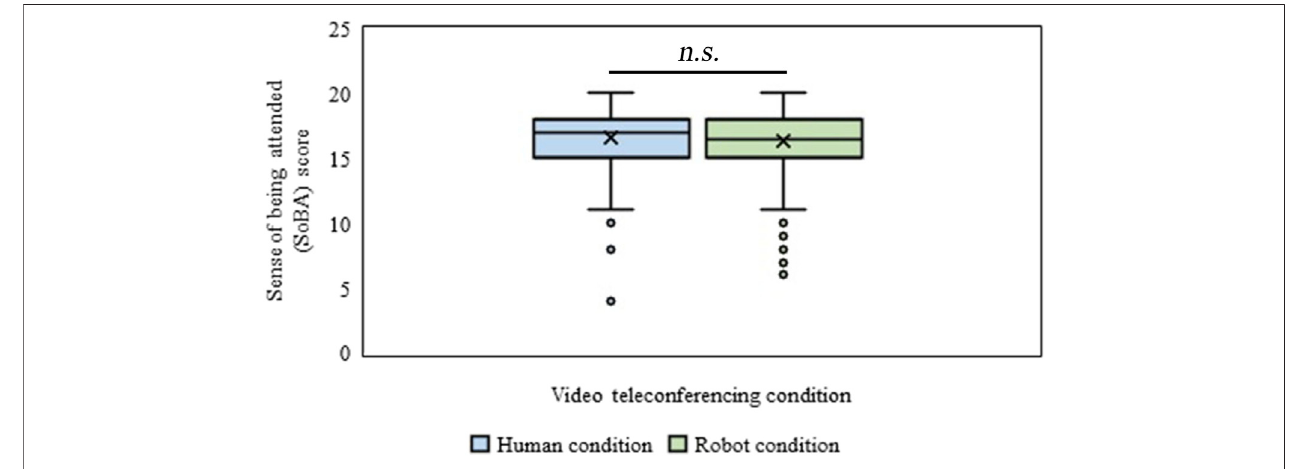
FIGURE 6 | Sense of being attended (SoBA) in Human and Robot conditions of Experiment- Ⅰ .